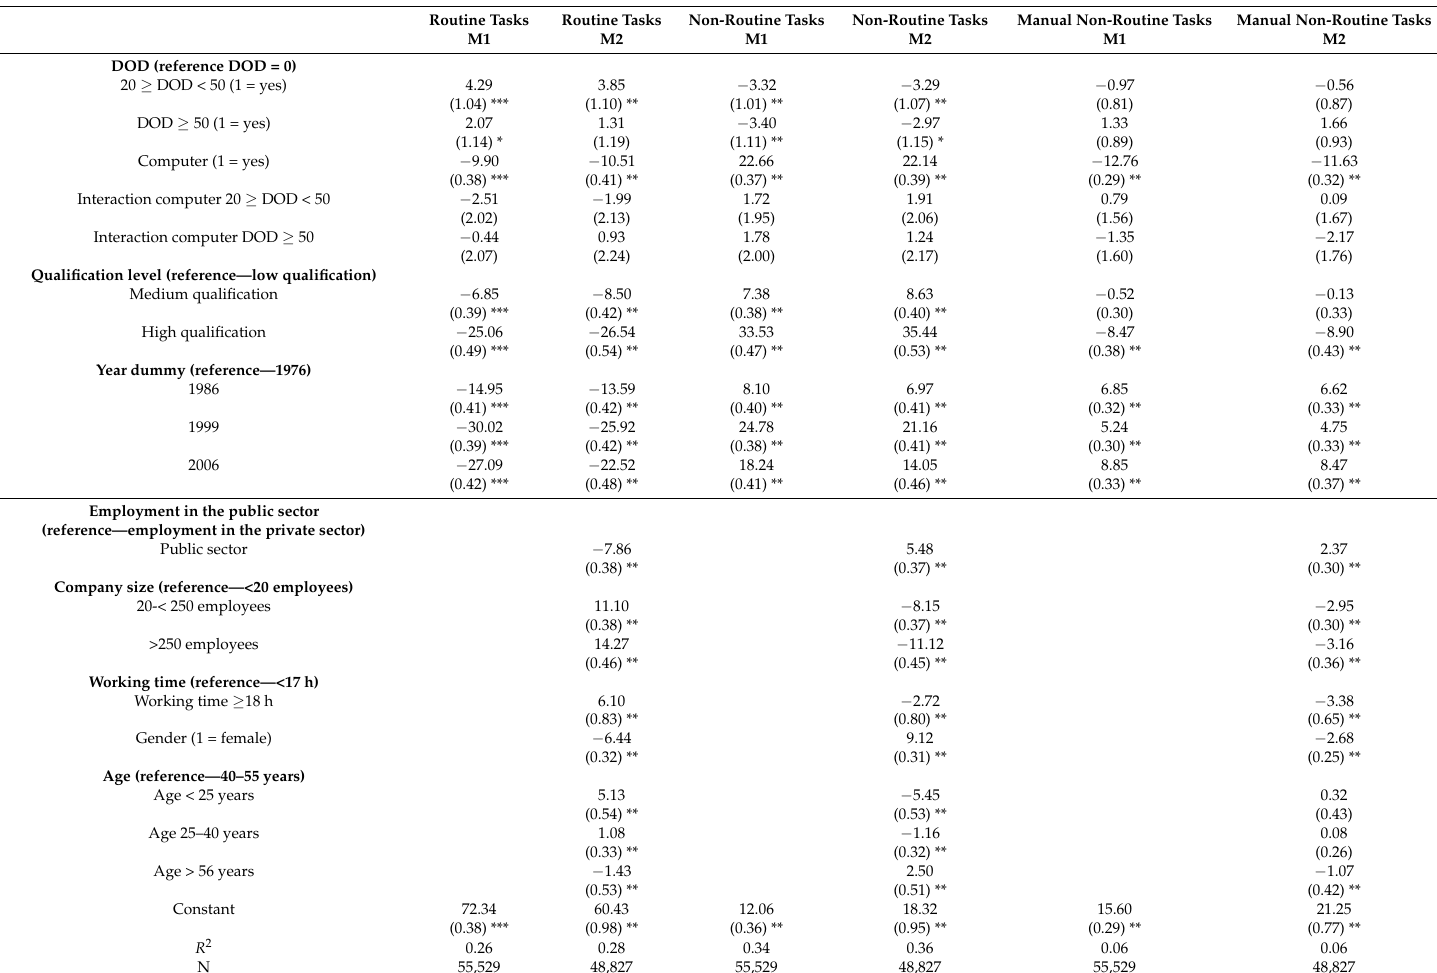
Table 4. Linear regressions—influence of computerization and disability on task focus, 1979–2006 (gross and net